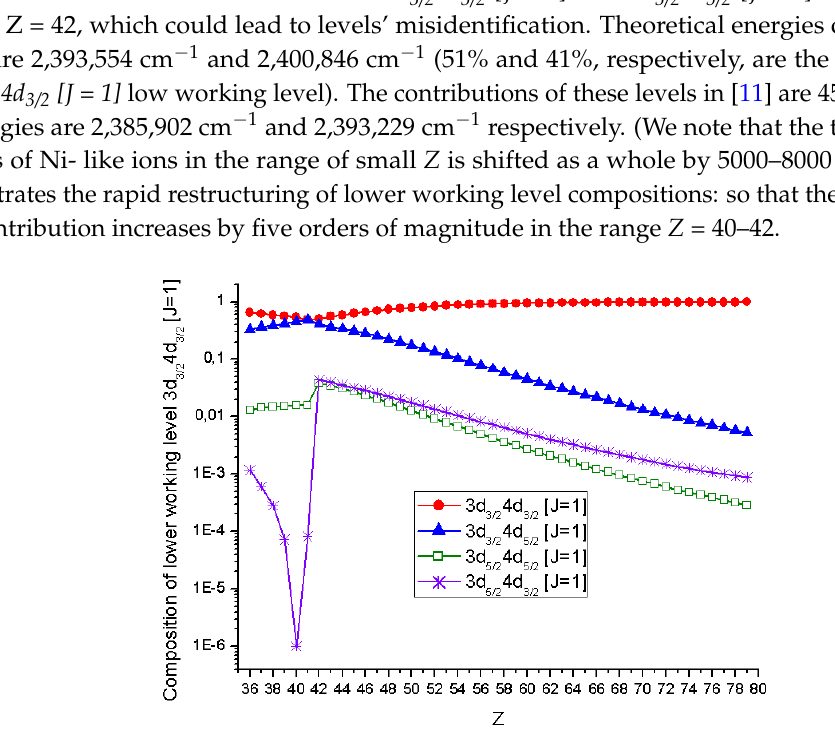
Figure 4. Composition of lower working level 3d 3/2 4d 3/2 [J = 1] along Ni-like sequence on a logarithmic scale.